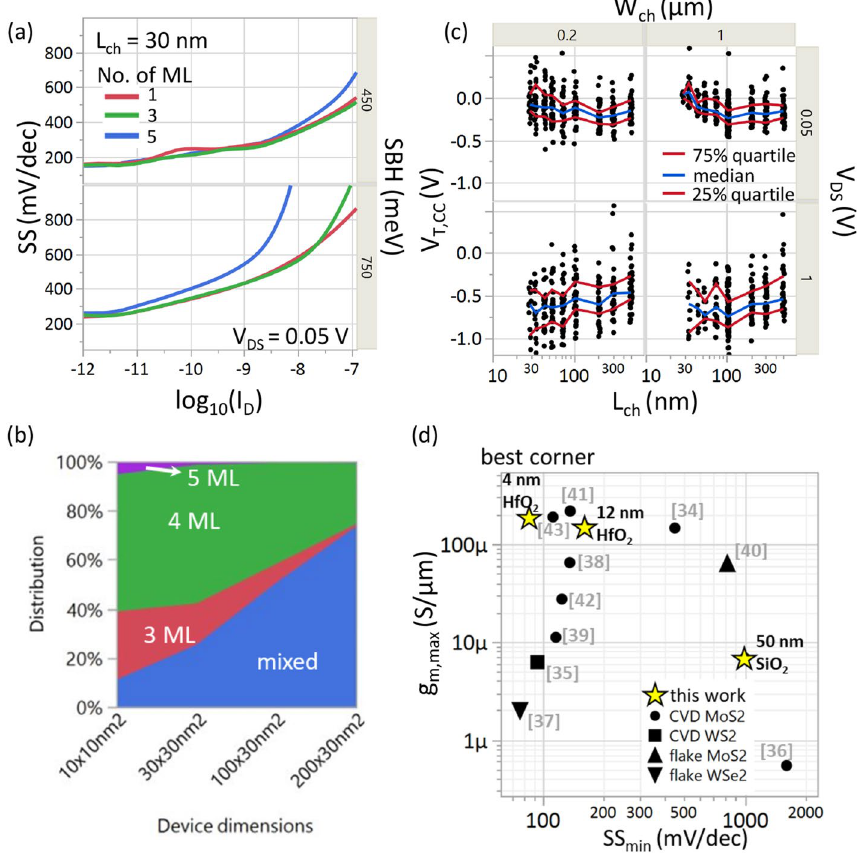
Figure 5. ( a ) Simulated SS versus log (I D ) for a uniform layer of 1, 3 and 5 monolayers of MoS 2 for SBH = 0.45 eV and 0.75 eV. For I D > 1e−9 A/μm, tunneling through Schottky barrier determines the SS. Subsequently, a thinner channel results in better gate control, shorter tunneling length and therefore better SS. ( b ) Probability distribution versus device dimensions (L ch x W ch ). AFM from Fig. 1a was used to compute the probability distribution for fabricating devices on only 3, 4, 5 or a combination of those (mixed). Our experimental devices have a 60–70% probability of being mixed, leading to non-uniform gate control across the channel and contact regions. ( c ) V T,CC versus L ch for two different W ch (200 nm, 1000 nm) and V DS (0.05 V, 1 V). No V T roll-off at V DS = 0.05 V due to excellent gate control over the channel for 12 nm HfO 2 . V T roll-off of about 200 mV for V DS = 1 V due to higher lateral-field at the source contact allowing for more carrier injection. No systematic V T deviation between W ch = 1 μm and 200 nm. (d) Benchmark plot showing g m,max versus SS min . All values are at V DS = 1 V except 39 —V DS = 0.1 V 34 ,—V DS = 0.5 V 40 ,—V DS = 1.2 V 37 ,—V DS = 1.5 V. In this work, 4 nm HfO 2 provides best SS = 86 mV/dec and g m,max = 185